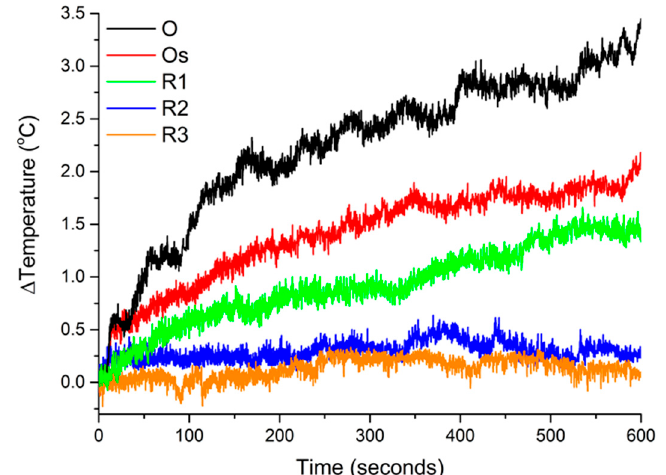
Figure 4. Magnetic hyperthermia activity of the various magnetic-plasmonic nanostructures all at a concentration of 0.2 mg/mL of Fe 3 O 4 .